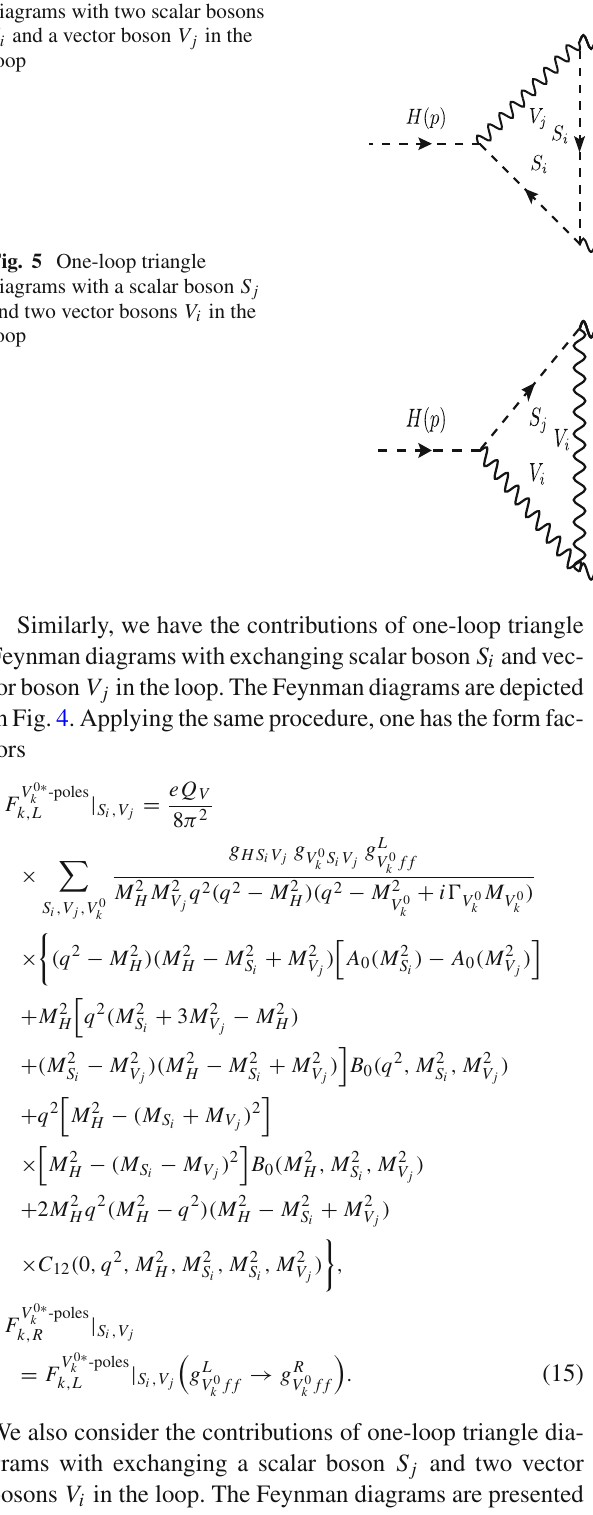
Fig. 4 One-loop triangle diagrams with two scalar bosons S i and a vector boson V j in the loop